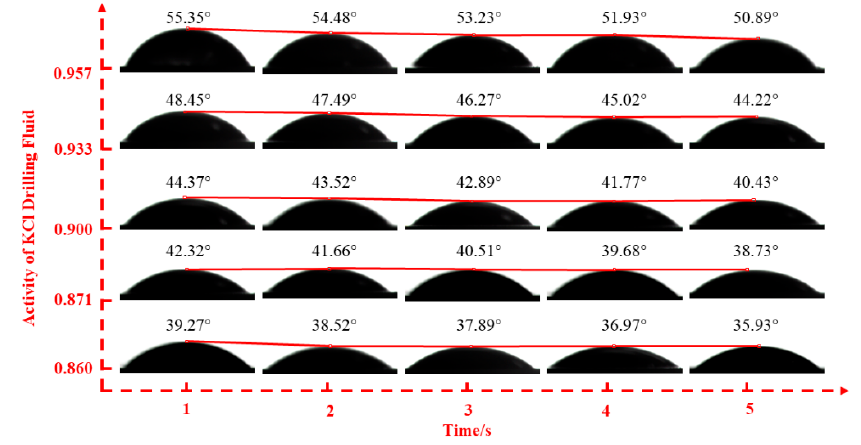
Figure 2. The evolution of fluid–shale contact angles with di ff erent activities of KCl drilling Figure 1. The evolution of fluid–shale contact angles with different activities of KCl drilling fluid.